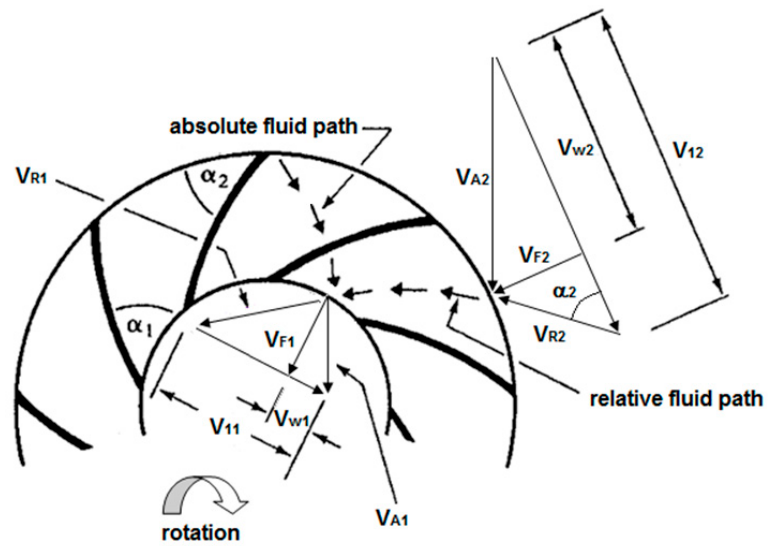
Figure 8. Inlet and outlet velocity triangles of the PAT impeller .